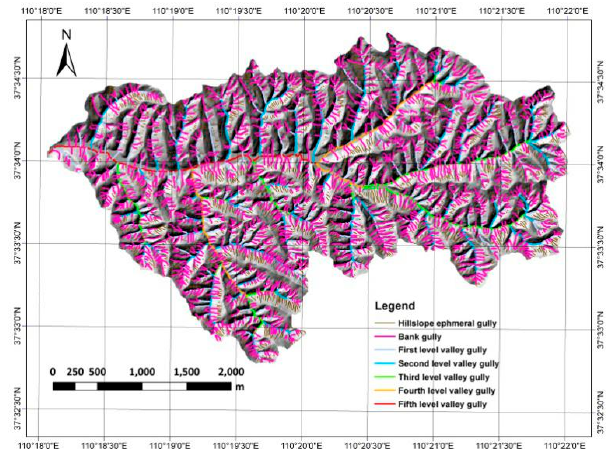
Figure 5. Result of gully system extraction in the study area. Gully system includes hillslope ephemeral gully, bank gully, and multilevel valley gully. The valley gullies were classified in five levels by the Strahler classification rule (1963).